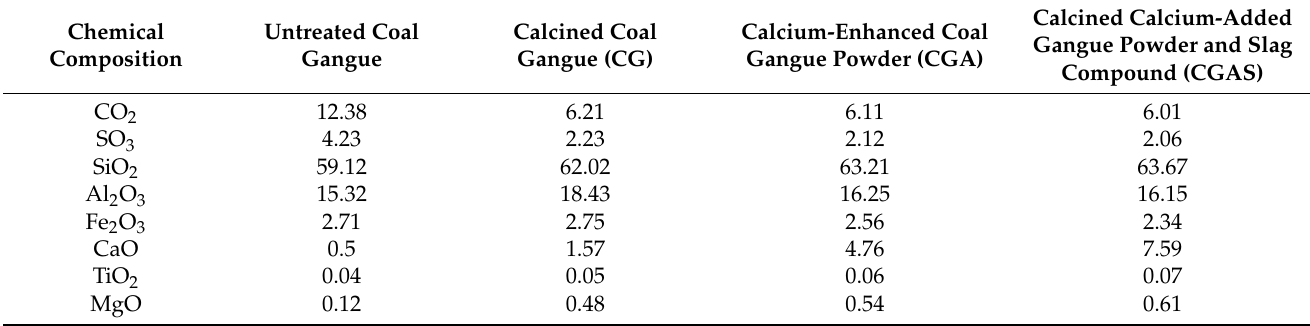
Table 3. XRF of different treatment methods for